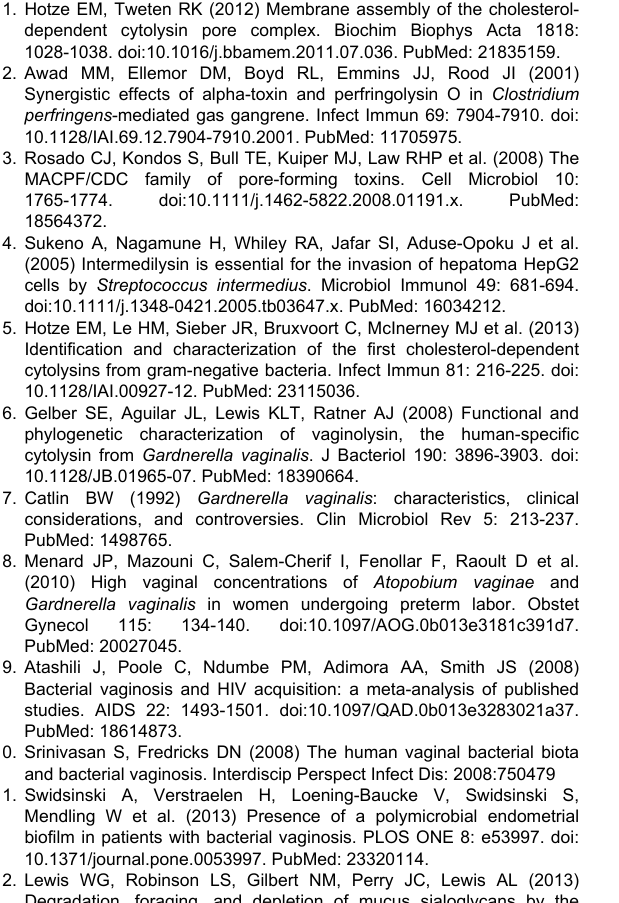
Figure S5. Binding of the MAbs 9B4 (A) and 21A5 (B) to rVLY and its mutants determined by an indirect ELISA. The MAbs were incubated at concentrations ranging from 3.7x10 -11 M to 46x10 -9 M on the microtiter plates coated with the respective antigens. For each MAb concentration, the mean OD values (+SD) calculated from triplicates are indicated. 450 Error bars represent 95% confidence intervals (CI) of mean value where indicated.